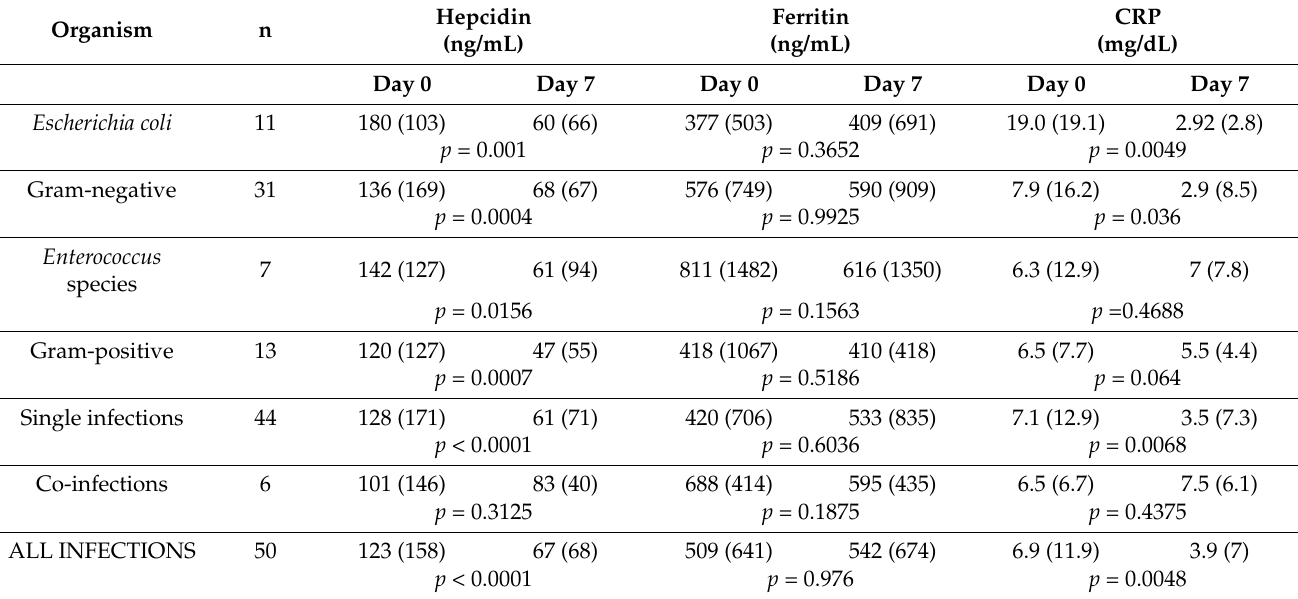
Table 3. Changes of measured variables between day 0 and day 7 in the subgroups of patients with different types of infection. Values are expressed as the median